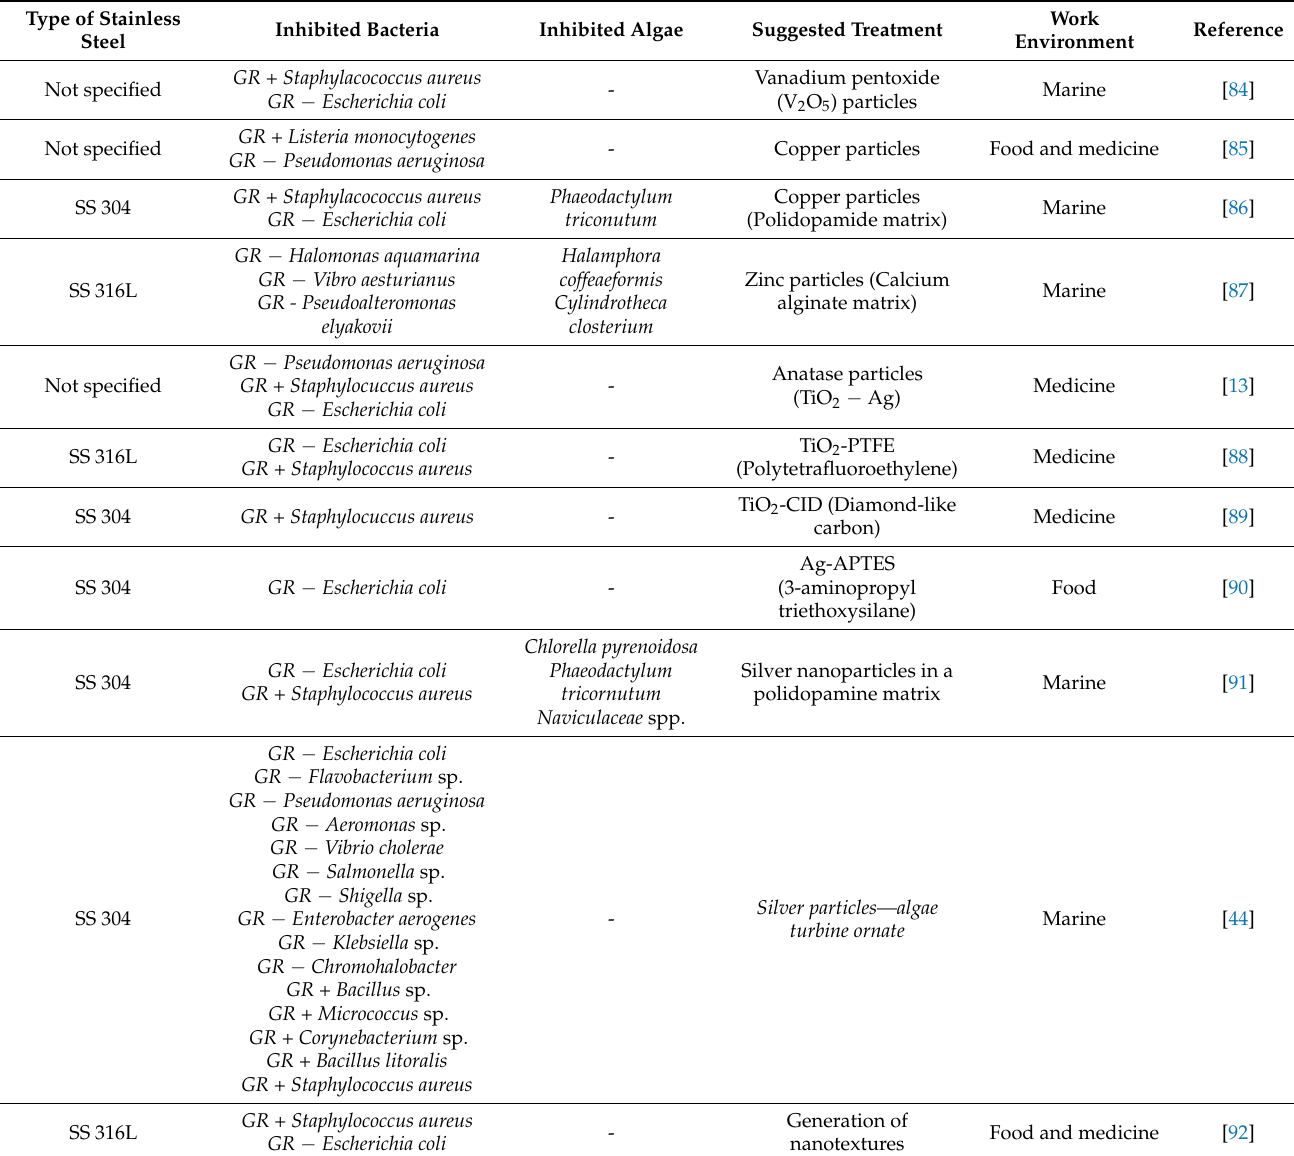
Table 2. Microorganisms that have shown reduction or inhibition of adhesion/growth on stainless steel surfaces because of nanotechnology